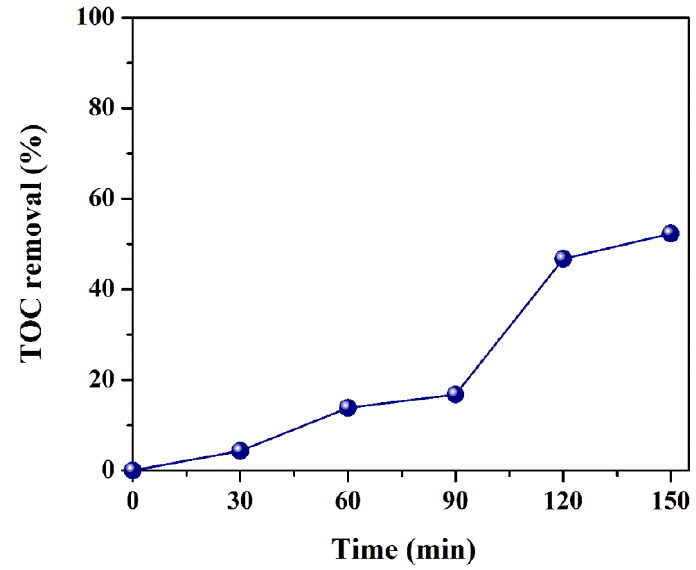
Figure 7. Total organic carbon (TOC) removal of RhB solution over CMS/BWO-2.